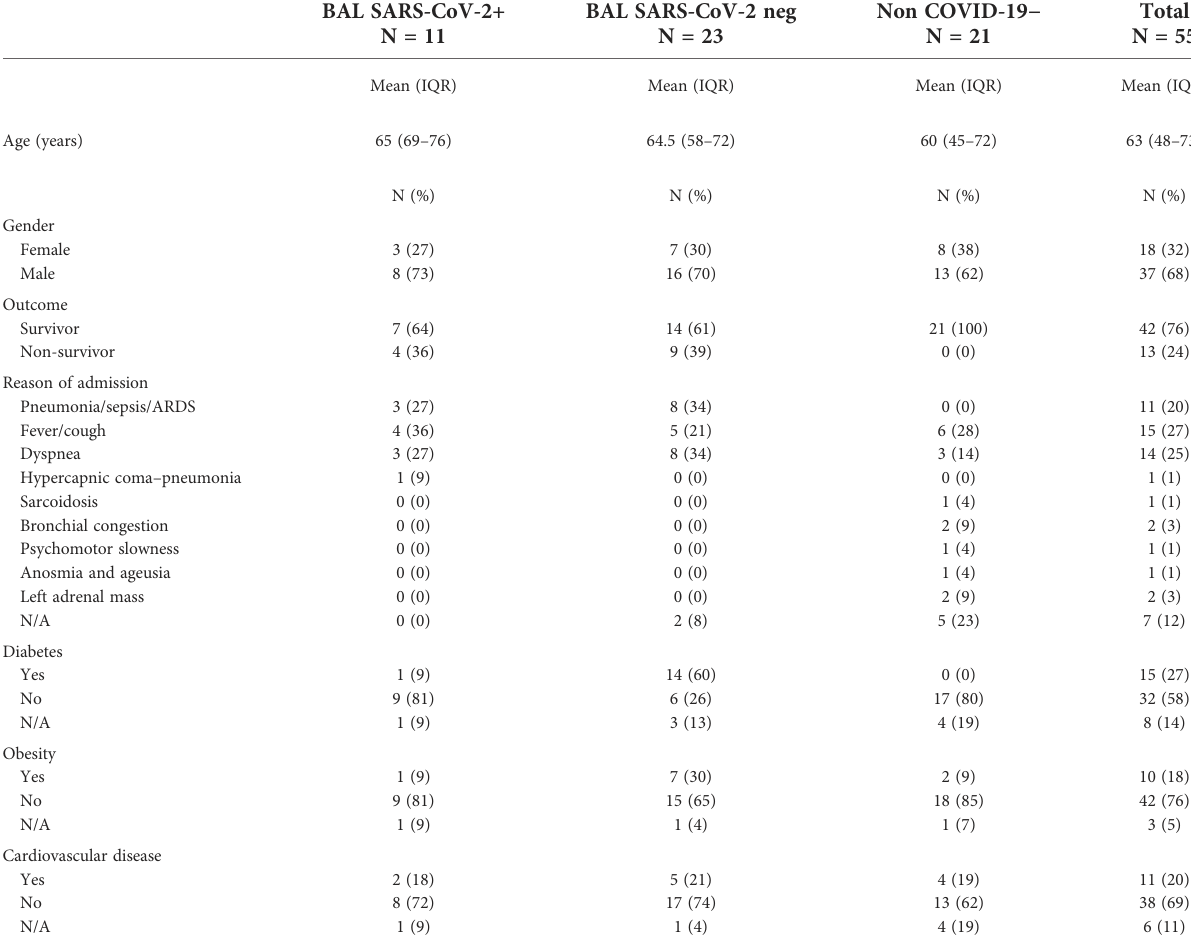
TABLE 1 Clinical data of individuals involved in the